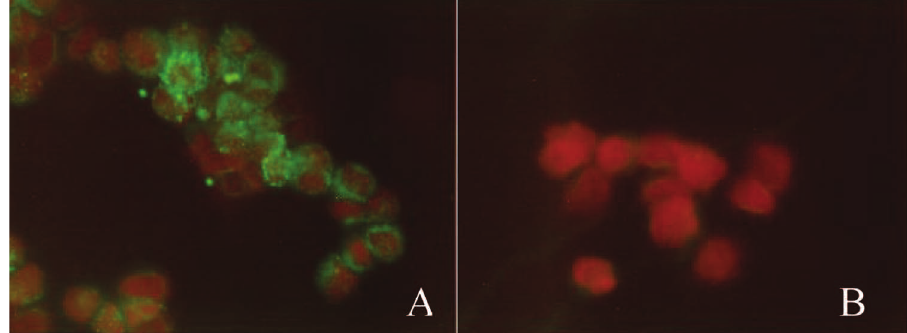
Figure 2 Evidence for B19 VP2 empty capsid bound to VTB. Biotinylated B19 VP2 empty capsids (15 m g/ml) were added to freshly isolated VTB. (a) Capsid binding was detected directly using streptavidin-labeled FITC (green). (b) Cells without added capsid revealed propidium iodine counterstain only (red)